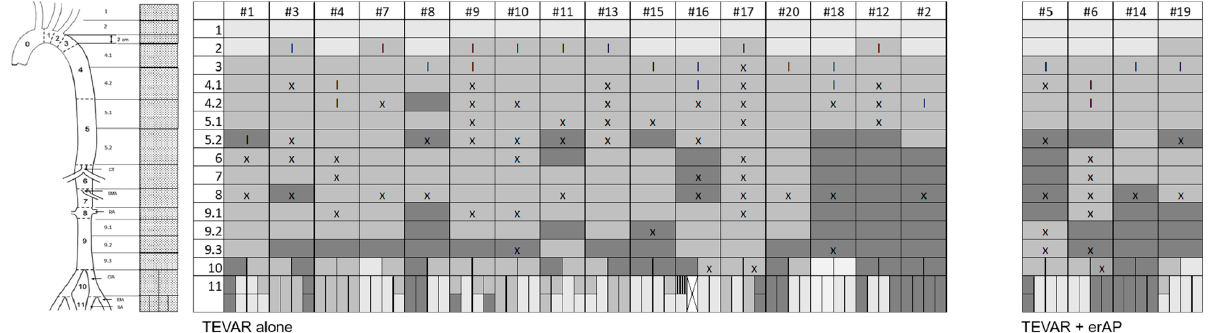
Figure 4. Explanatory caption of Figure 3A–C as well as Figure 5.